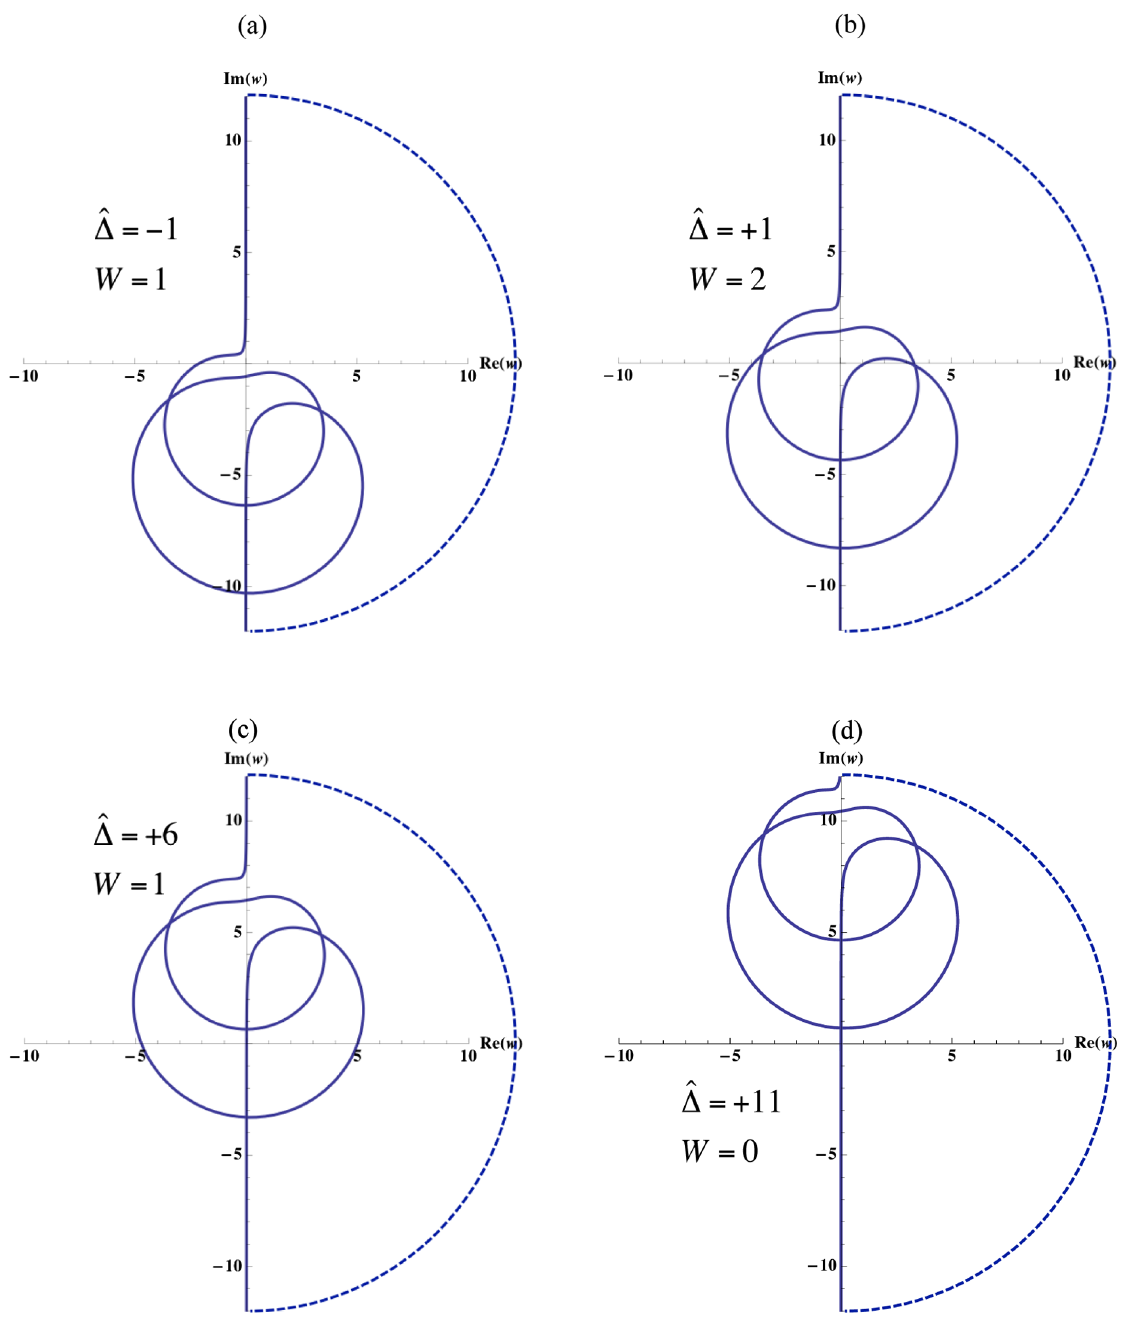
FIG. 6. Parts (a), (b), (c), and (d) are plots of w ð C Þ (with a dashed semicircle to be pushed to infinity) for various characteristic values for ^(cid:2) ¼ (cid:1) 1 , 1, 6, and 11 correspondingly. The energy distribution is shown in Fig.